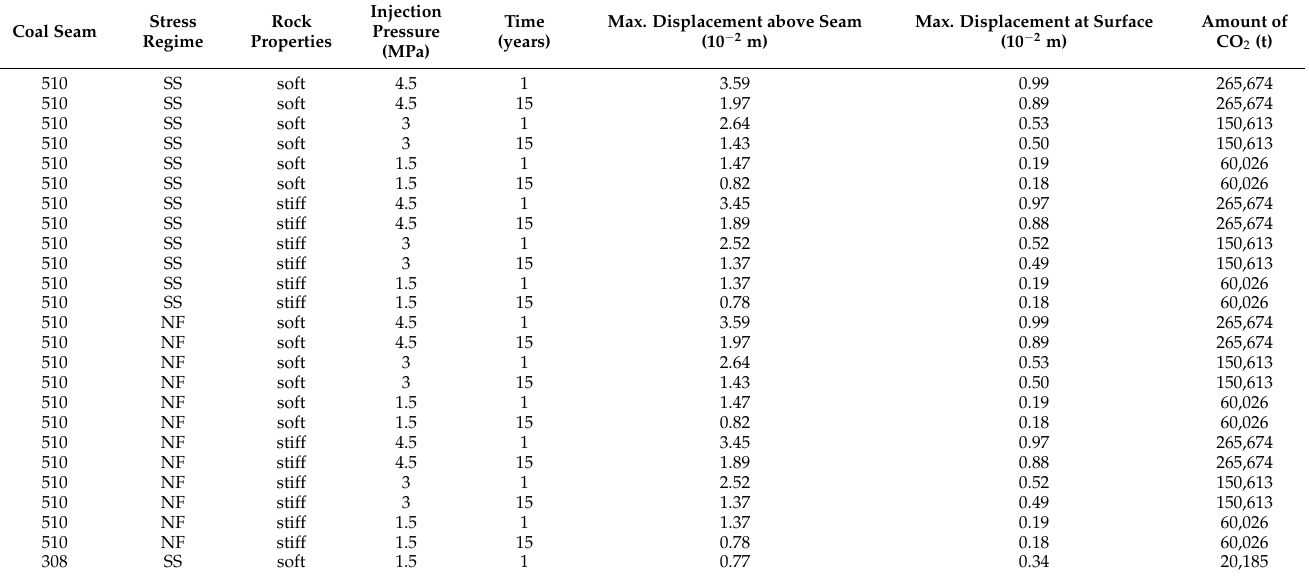
Table A1. All scenarios of the investigated sensitivity analysis regarding initial conditions, maximum displacements and the respective maximum amount of stored CO 2